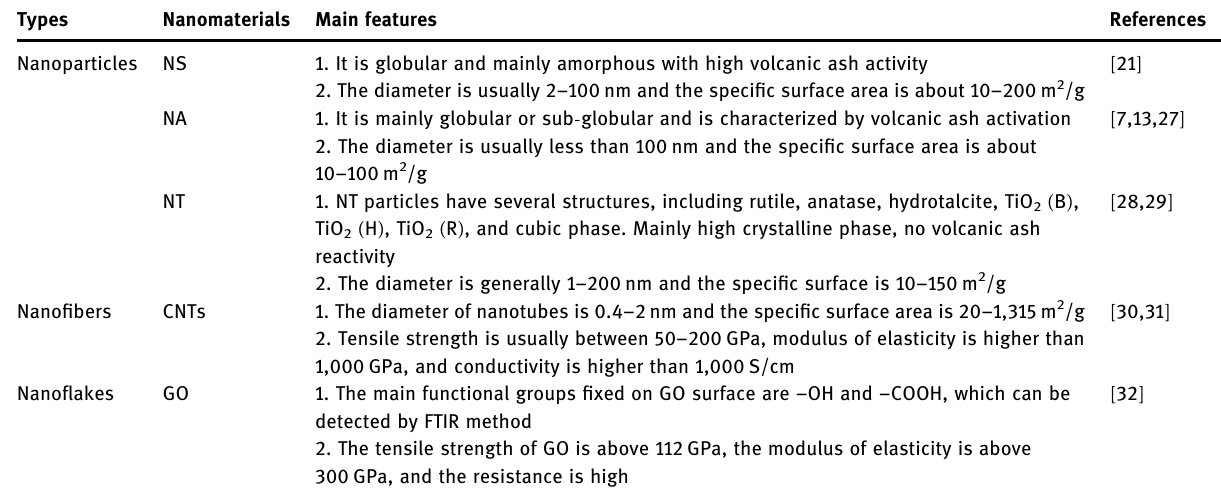
Table 1: Main properties of